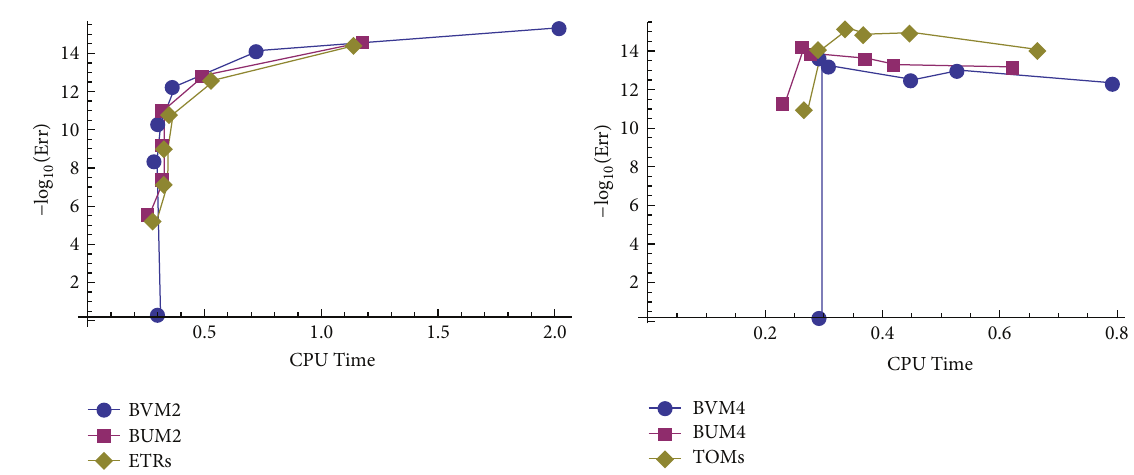
Figure 3: Efficiency curves for Example